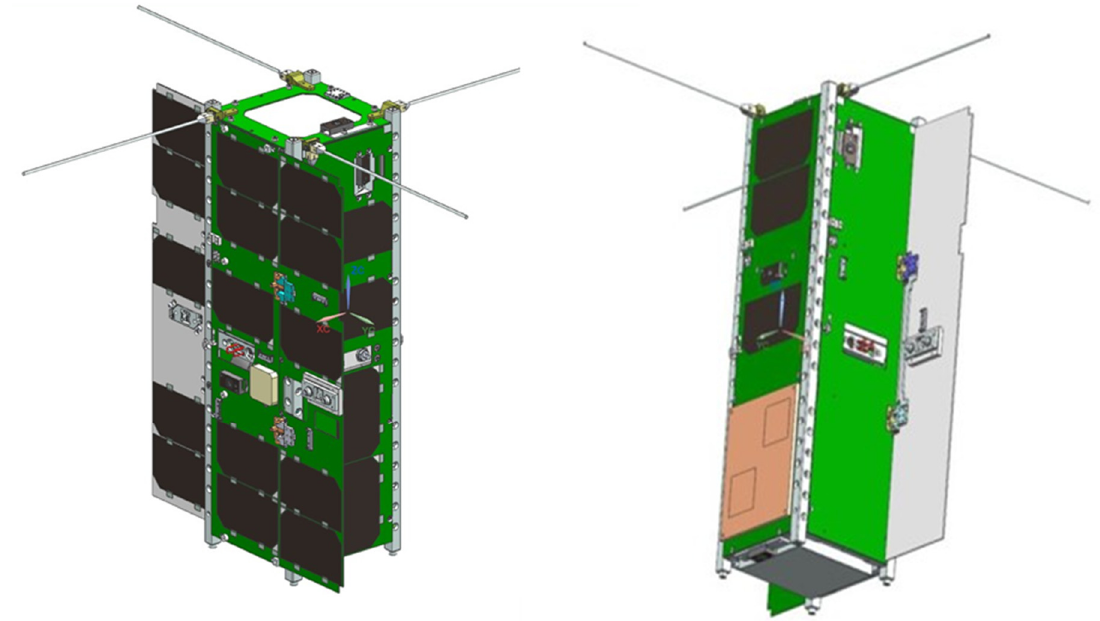
Figure 6. Distribution of solar cells in each Light-1 solar panel.